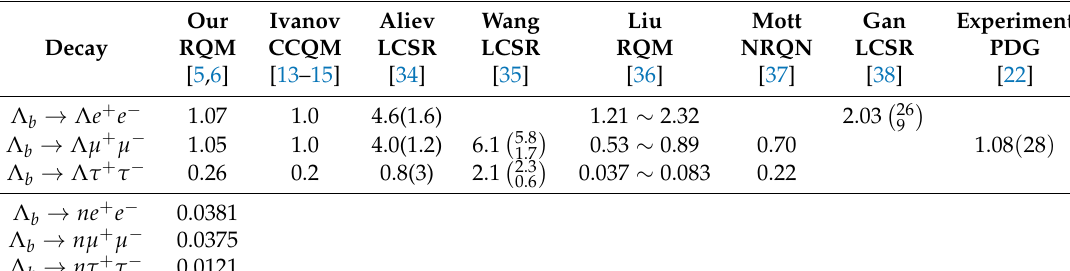
Table 6. Comparison of theoretical predictions for baryon rare decay branching fractions ( available experimental